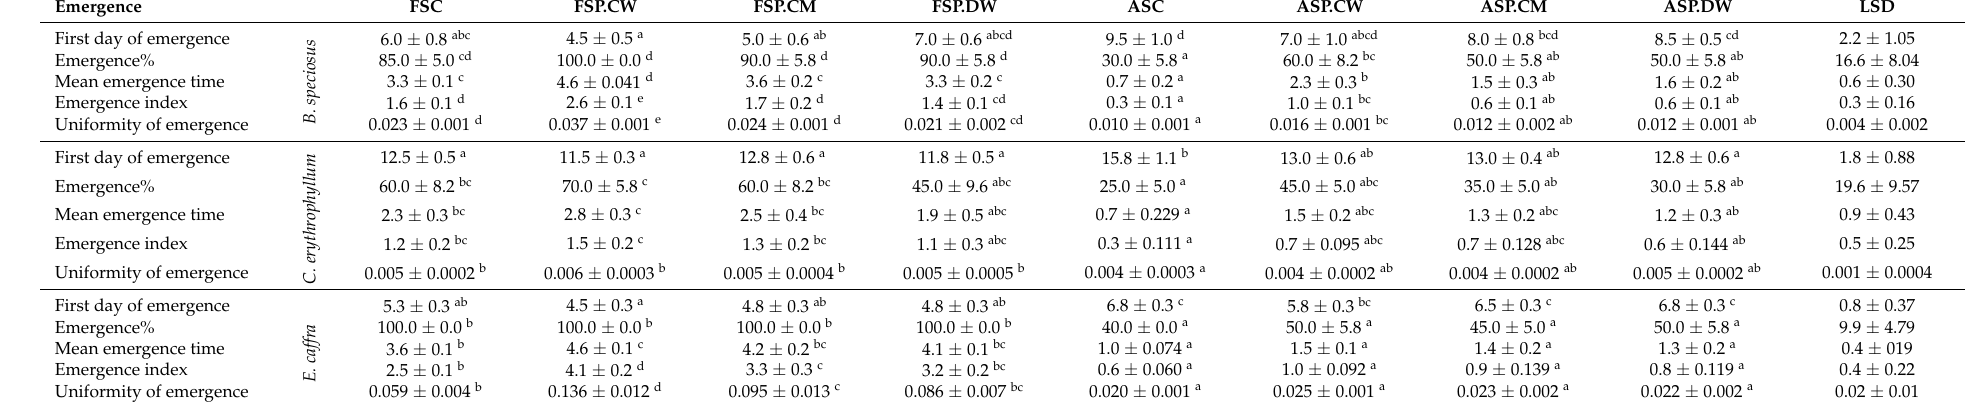
Table 1. Effects of cathodic water, calcium magnesium solution and deionized water treatments on the emergence of Bolusanthus speciosus, Combretum erythrophyllum and Erythrina caffra . Emergence FSC FSP.CW FSP.CM FSP.DW ASC ASP.CW ASP.CM ASP.DW LSD